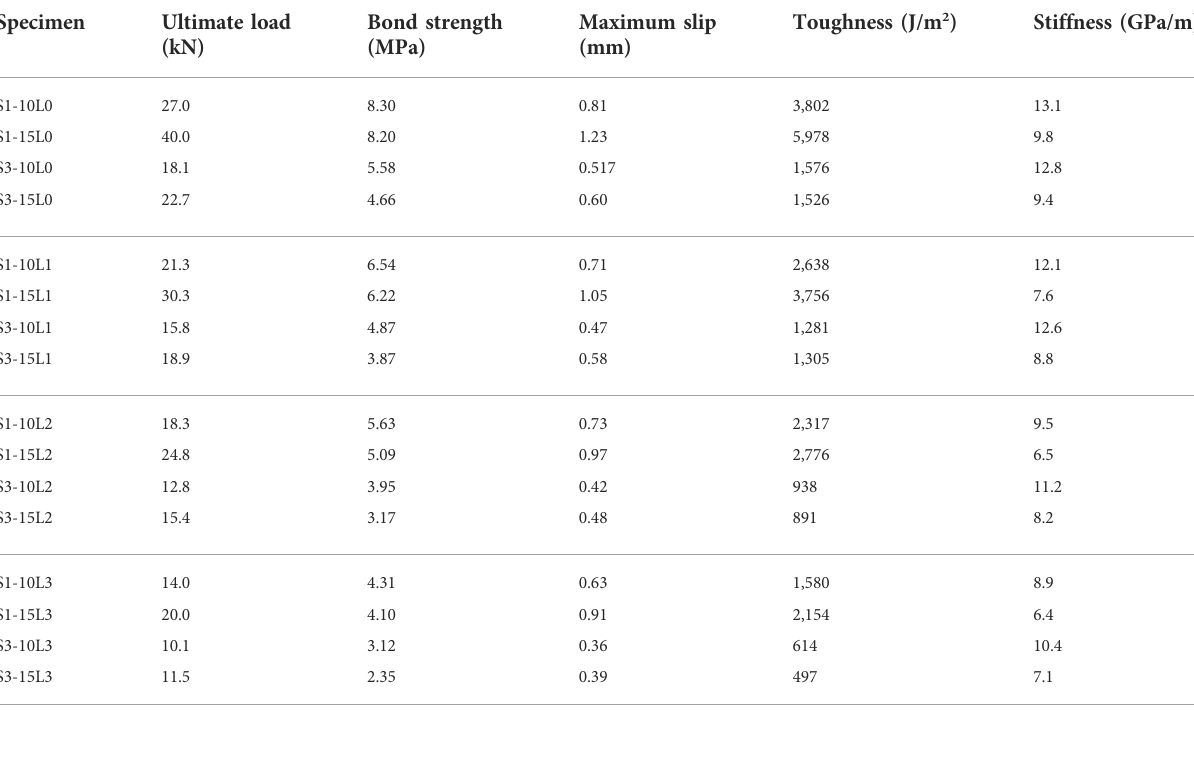
TABLE 4 Bond characteristics for one NSM strip.